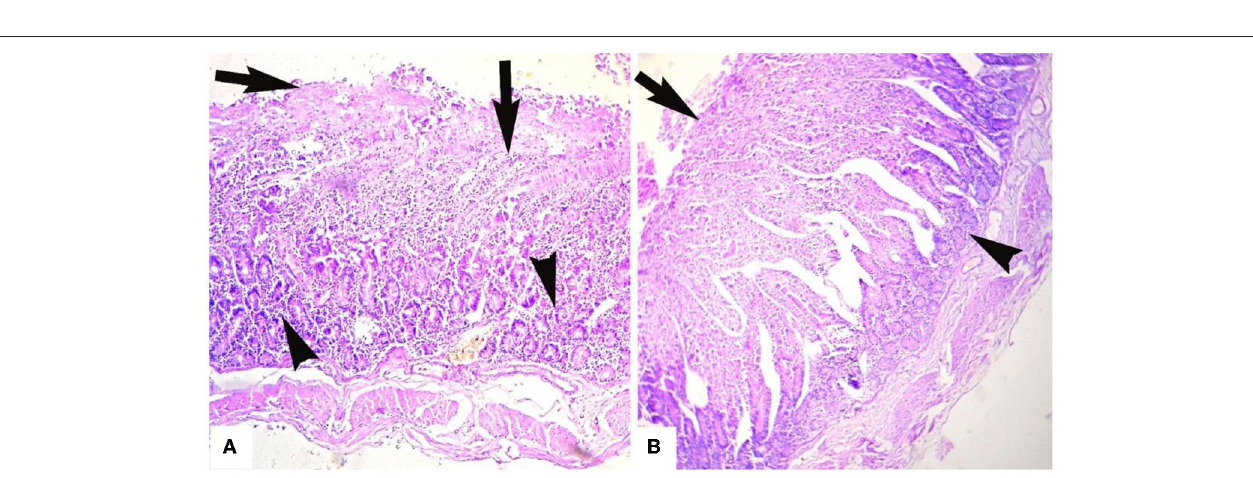
FIGURE 2 | Photomicrograph of hemorrhagic kidneys of goats that died of enterotoxemia showing (A) tubules studded with erythrocytes (arrows), (B) erythrocytes extensively present in tubules (arrow) and detachment of endothelial linings of various renal tubules (arrowheads), and (C) detachment/sloughing of endothelium from most of the renal tubules (arrowheads) and congestion. H and E stain. × 40.